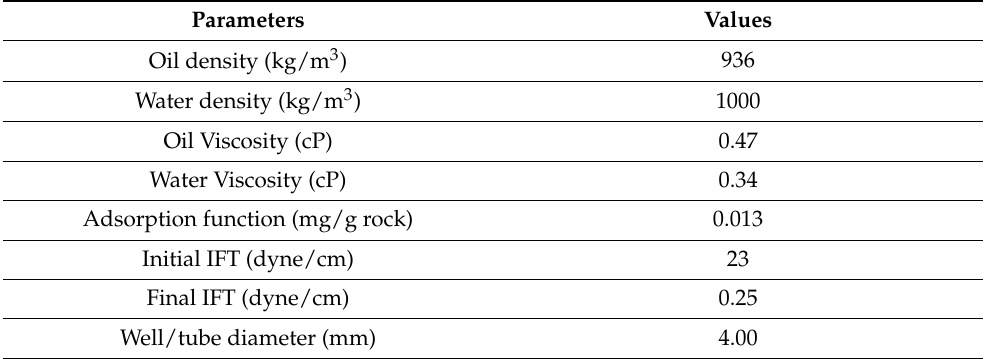
Table A7. Formulation Fluid